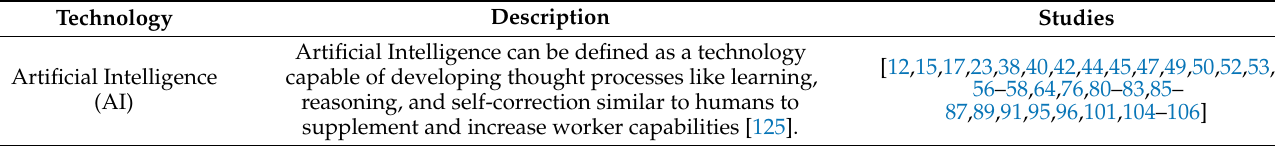
Table 5. Identified industry 4.0 technologies in the systematic literature review (SLR). Description